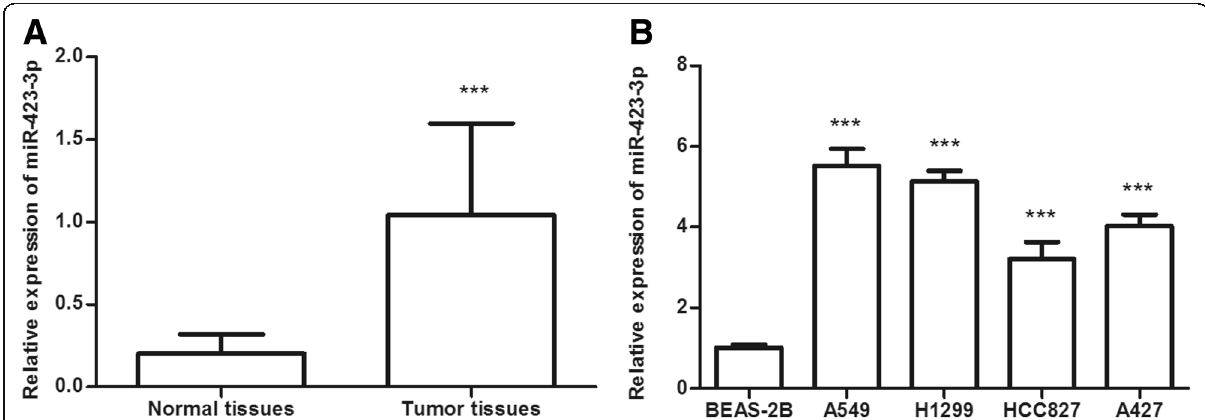
Fig. 1 Expression of miR-423-3p in lung cancer tissues and cell lines. a Expression of miR-423-3p was upregulated in lung cancer tissues compared with normal tissues. (*** P < 0.001). b Expression of miR-423-3p was increased in lung cancer cell lines (A549, H1299, HCC827, and A427) compared with normal cell line BEAS-2B. (*** P <